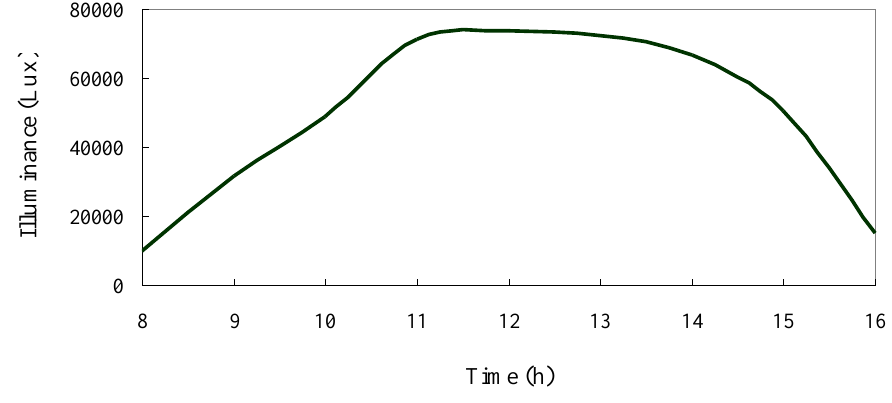
Figure 11. Variation in illuminance of light incident on BIPV panel between 8:00 am and 4:00 pm during a typical summer